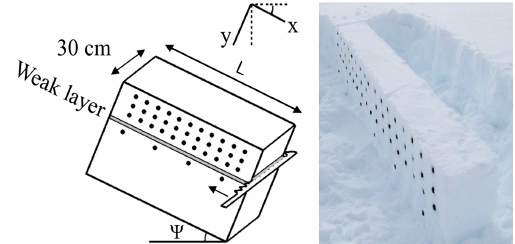
Figure 2. Schematic drawing and picture of the propagation saw test (PST). The black dots are markers used for particle tracking in order to measure the displacement of the slab. The column length is denoted L . Adapted from van Herwijnen et al.